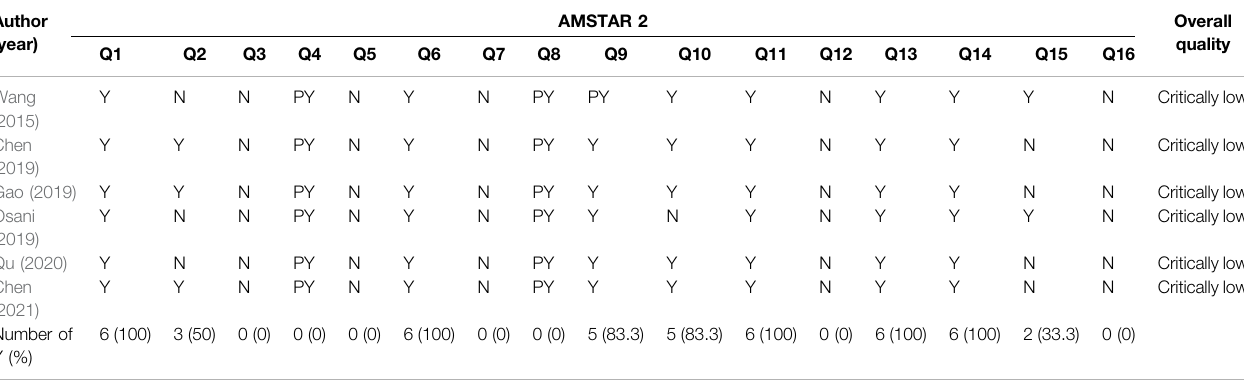
TABLE 3 | Results of the AMSTAR 2